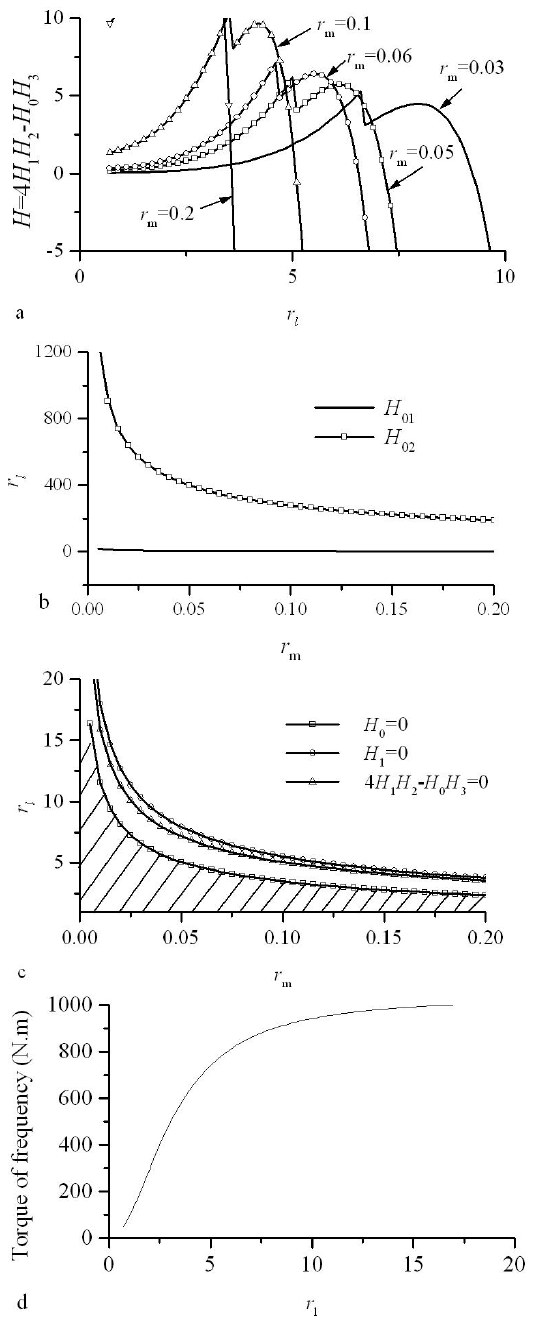
Fig. 1. Numeric results when ω nx /ω ∗ m0 = ω ny /ω ∗ m0 = ω n ψ /ω ∗ m0 = 4.5 and η = 0 . 5 : a- distribution diagram of H zero value points; b-the distribution diagram of zero point in r m r l -plane; c-the stability domain of synchronous operation; d-torque of frequency capture. them increases gradually because the electromagnetic torque of motor 1 is greater than that of motor 2, as shown in Fig. 4(b). When the phase difference is in the interval of ( − 180 ◦ , 0 ◦ ), the torque of frequency capture acts on motor 1 as driving torque, and on motor 2 as load torque, which makes the phase difference increase rapidly and tends